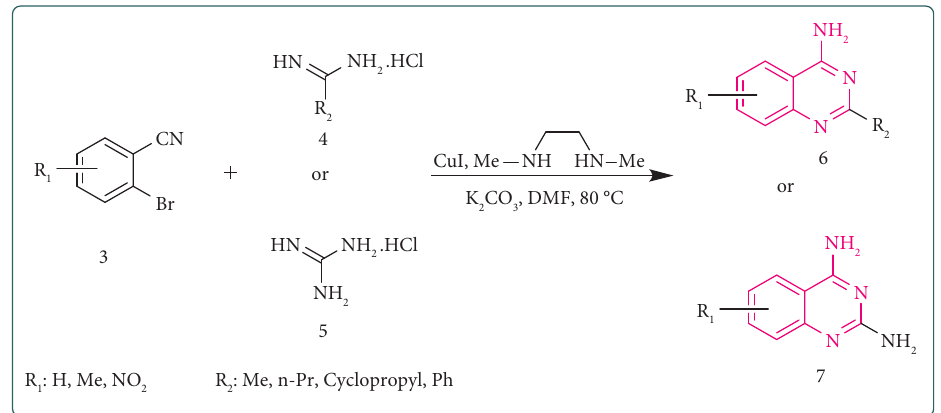
Scheme 2: Copper-catalyzed synthesis of 4-aminoquinazoline and 2,4-diaminoquinazoline